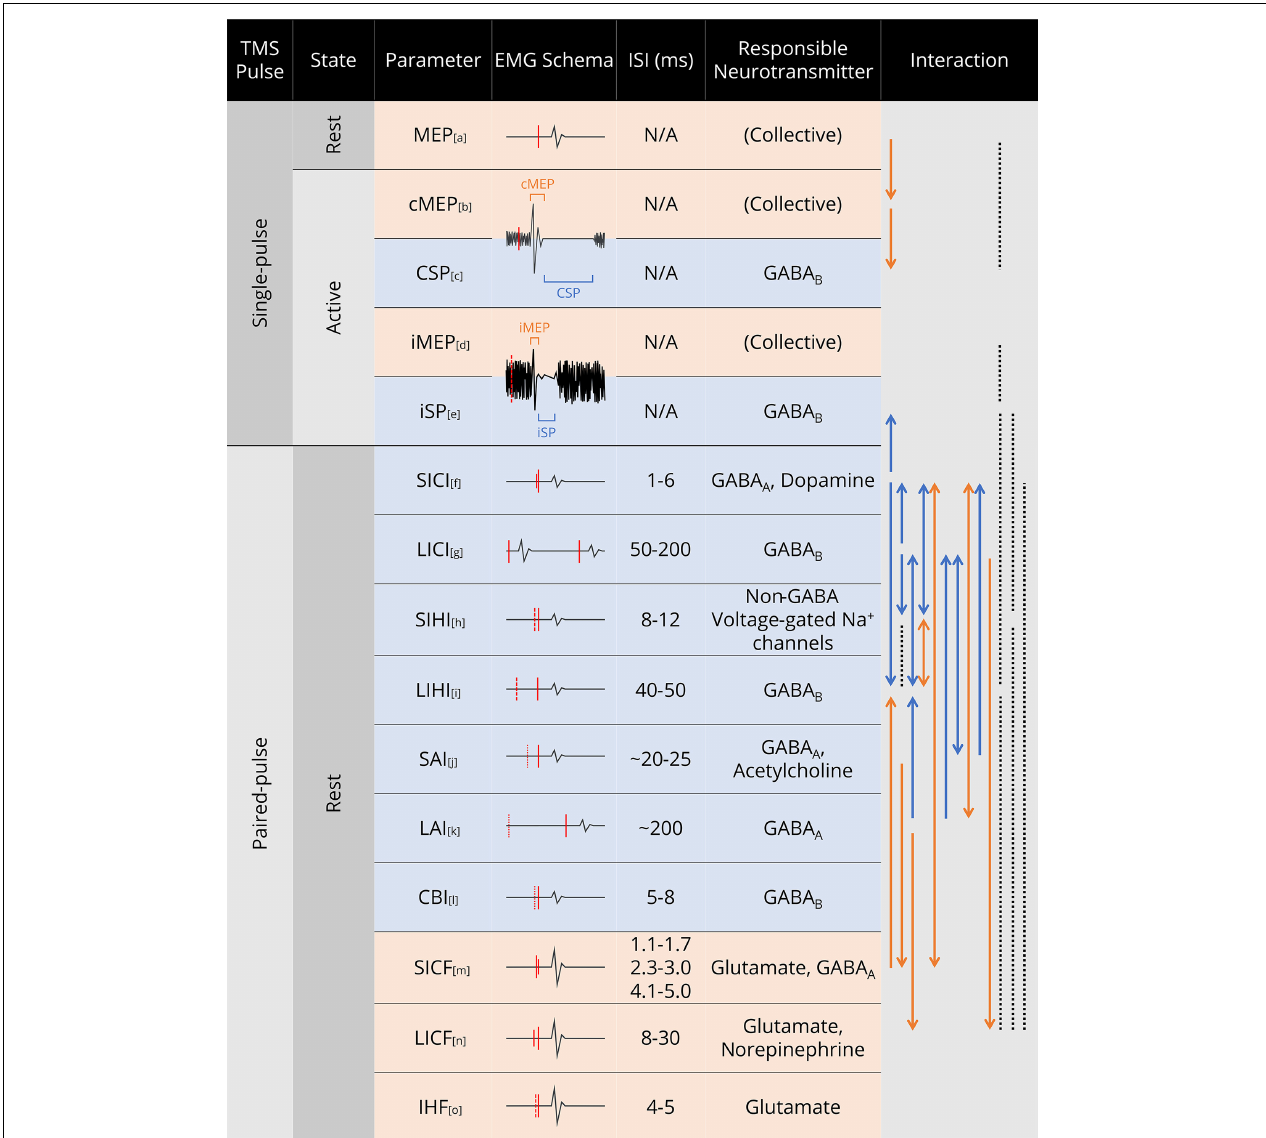
FIGURE 3 | Summary of common TMS paradigms and parameters. In the EMG Schema column, red solid line denotes TMS pulse; red dashed line denotes TMS pulse in the contralateral hemisphere, with the line length indicating stimulus intensity; red dotted line denotes median nerve electric stimulus in SAI and long interval afferent inhibition (LAI), and cerebellar stimulus in CBI. In the Interaction column, solid line denotes the relationship between the two parameters at both ends; dotted line denotes no interaction/correlation was observed between the two parameters; arrow denotes the direction of the interaction (facilitation/inhibition); for line colors, orange denotes facilitation and blue denotes inhibition. Abbreviations: cMEP, contralateral MEP; CSP, cortical silent period; iMEP, ipsilateral MEP; iSP, ipsilateral silent period; SICI, short interval intracortical inhibition; LICI, long interval intracortical inhibition; SIHI, short interval interhemispheric inhibition; LIHI, long interval interhemispheric inhibition; SAI, short latency afferent inhibition; LAI, long latency afferent inhibition; CBI, cerebellar inhibition; SICF, short interval intracortical facilitation; LICF, long interval intracortical facilitation; IHF, interhemispheric facilitation. References for the paradigms and interactions: a. (Izumi, 2001; Rossini et al., 2015); b. (Ngomo et al., 2012); c. (Orth and Rothwell, 2004); d. (Wassermann et al., 1994; Tazoe and Perez, 2014); e. (Chen et al., 2003; Jung et al., 2006); f. (Chen, 2004; Trompetto et al., 2004; Lee et al., 2007; Ni et al., 2007); g. (Daskalakis et al., 2002; Lee et al., 2007; Udupa et al., 2009); h. (Daskalakis et al., 2002;